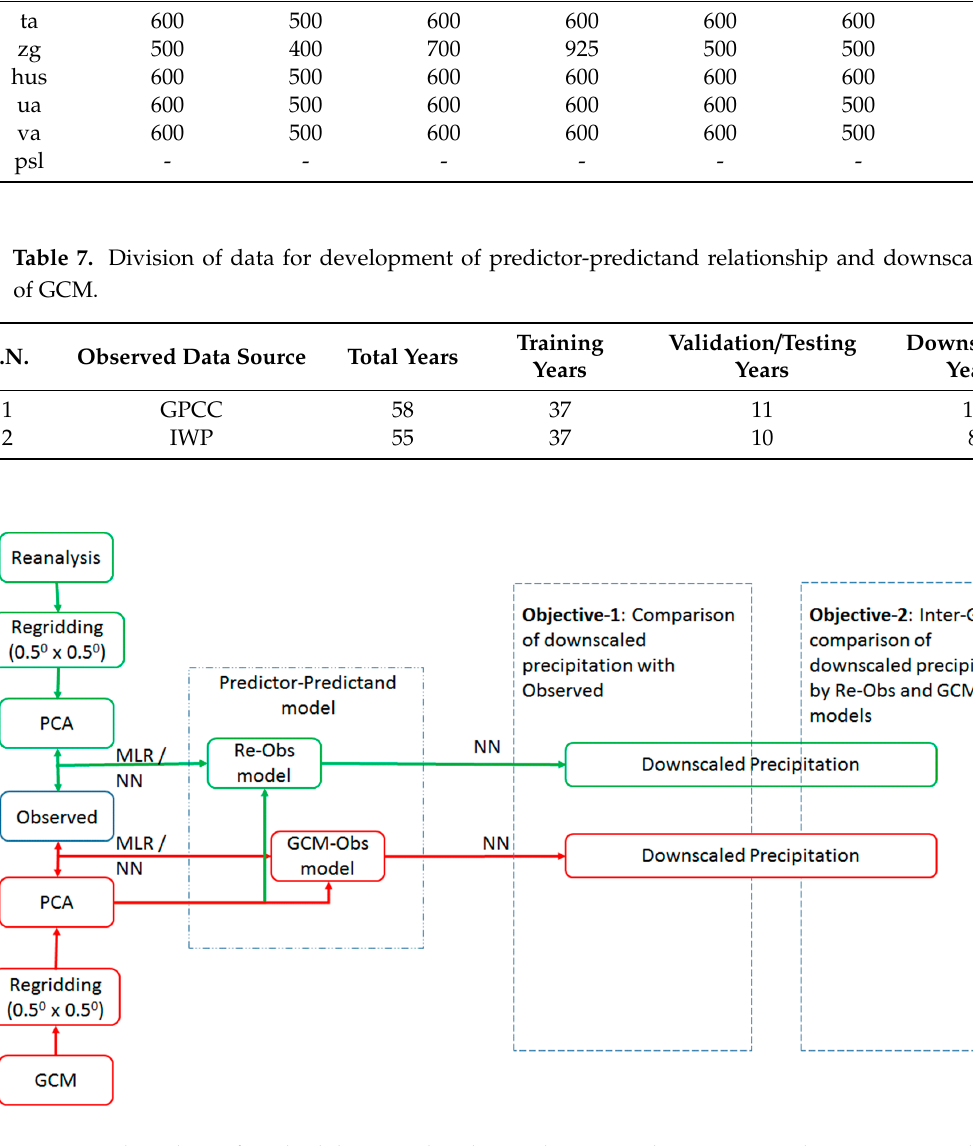
Figure 5. Flow chart of methodology used in this study. PCA indicates principal component analysis. MLR/NN represents development of predictor-predictand model using multiple linear regression and artificial neural network methods, respectively.